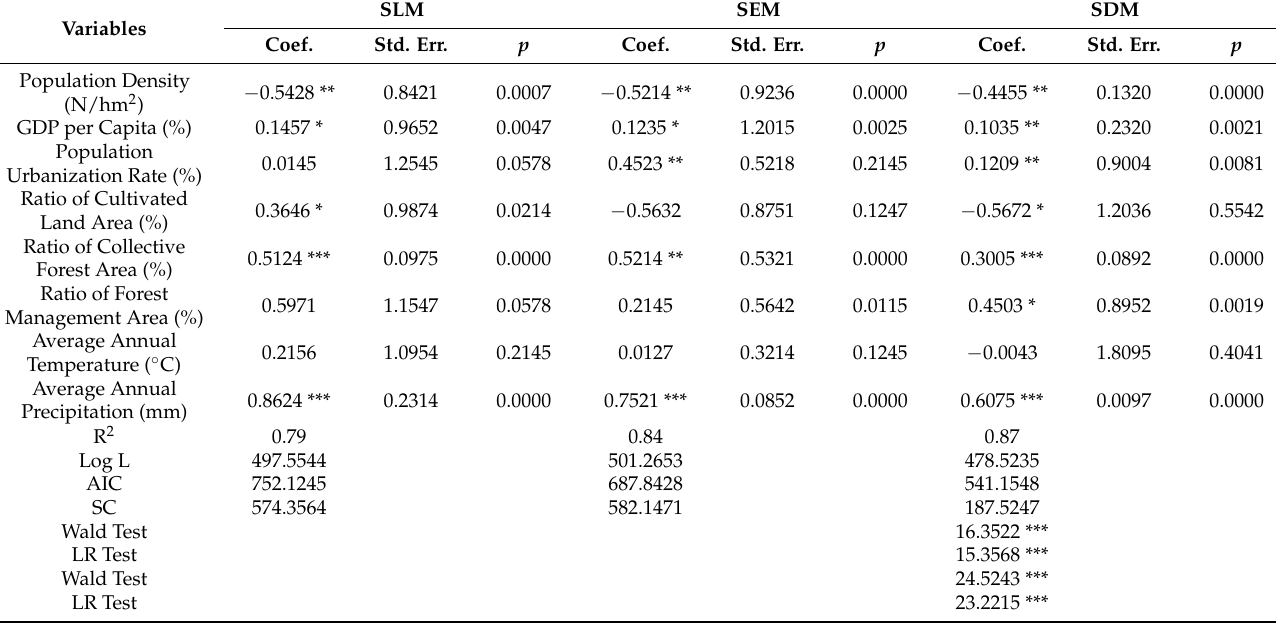
Table 6. Regression coefficient estimates results of SLM, SEM, and